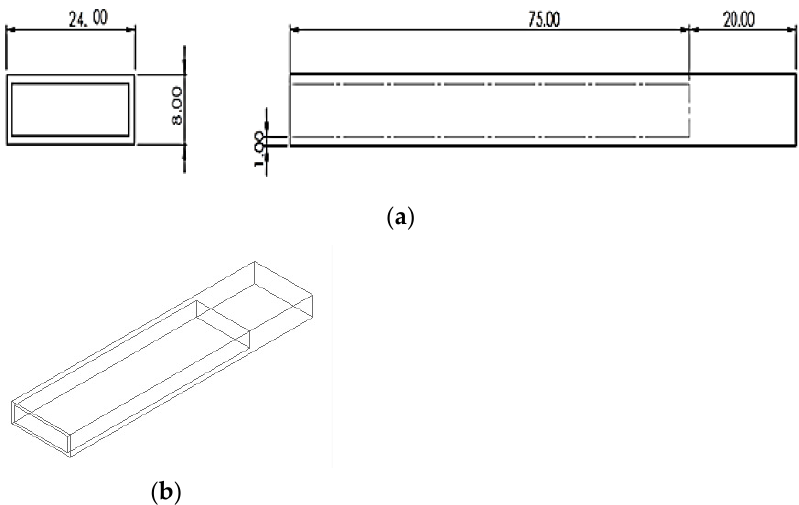
Figure 3. Schematic view of the flexible PVC–MR Fluid cantilever beam ( a ) Dimensional view of the specimen (all dimensions are in mm) ( b ) Wireframe model of the specimen.